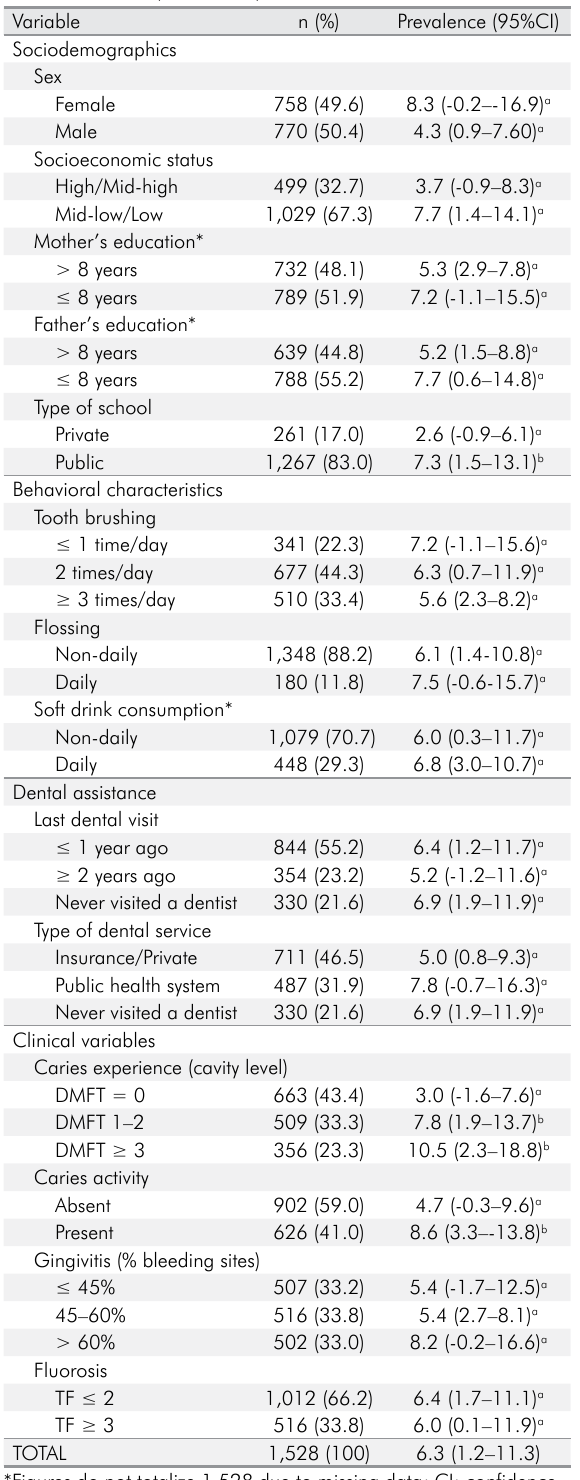
Table 1. Sample distribution and the prevalence of underlying dentin shadows (n